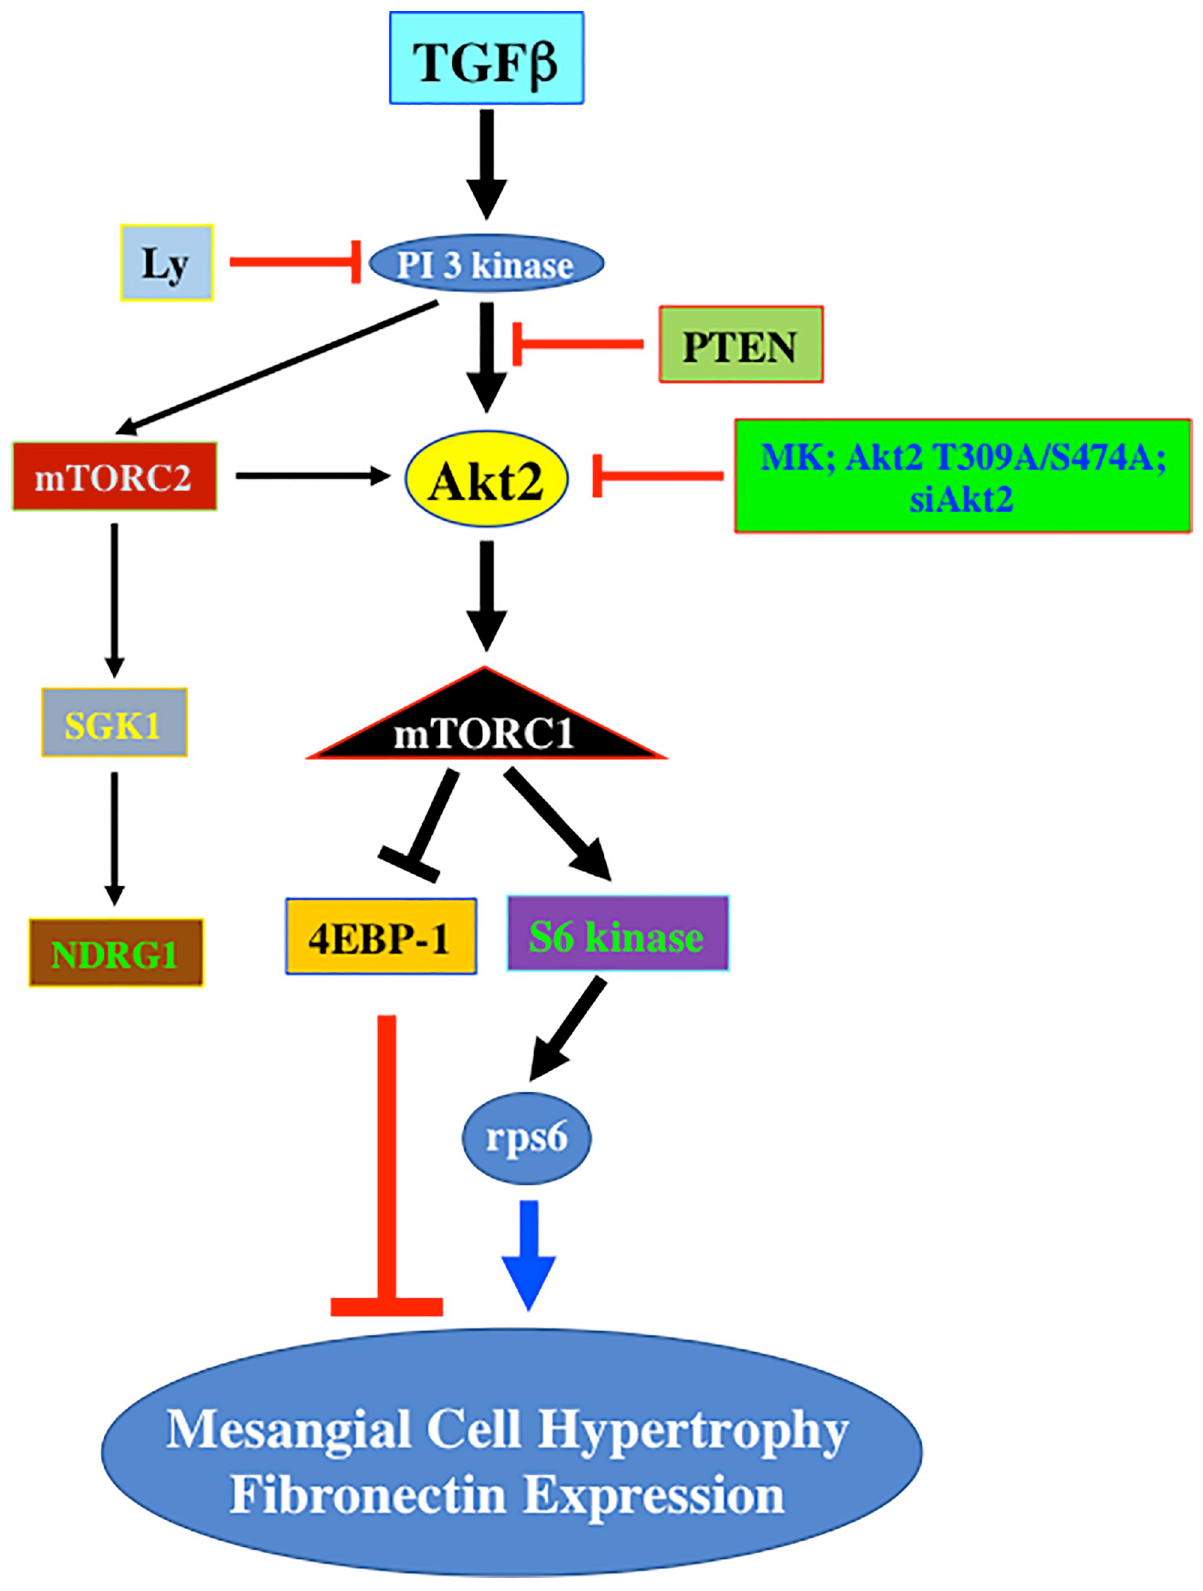
Fig 11. Schematic summary of results presented in this study. https://doi.org/10.1371/journal.pone.0207285.g011 PLOS ONE | https://doi.org/10.1371/journal.pone.0207285 November16,